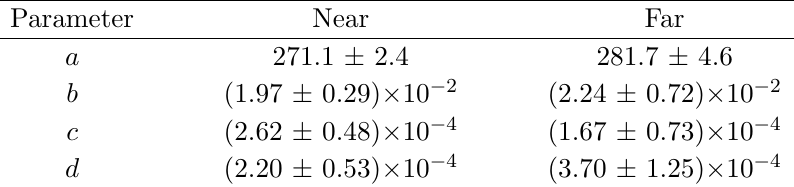
Table 1 . Fitted parameter values of energy conversion functions at the near and far detectors. The global correlation values are found to be roughly 0.99 for all of (cid:12)tted